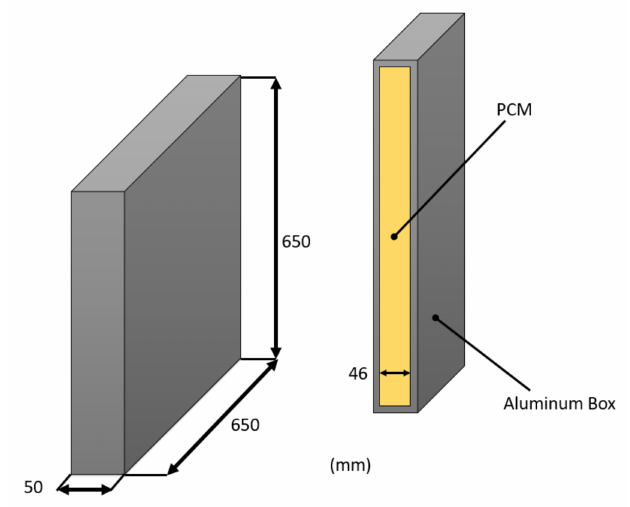
Figure 2. Schematic representation of the device for this proof-of-concept study (1